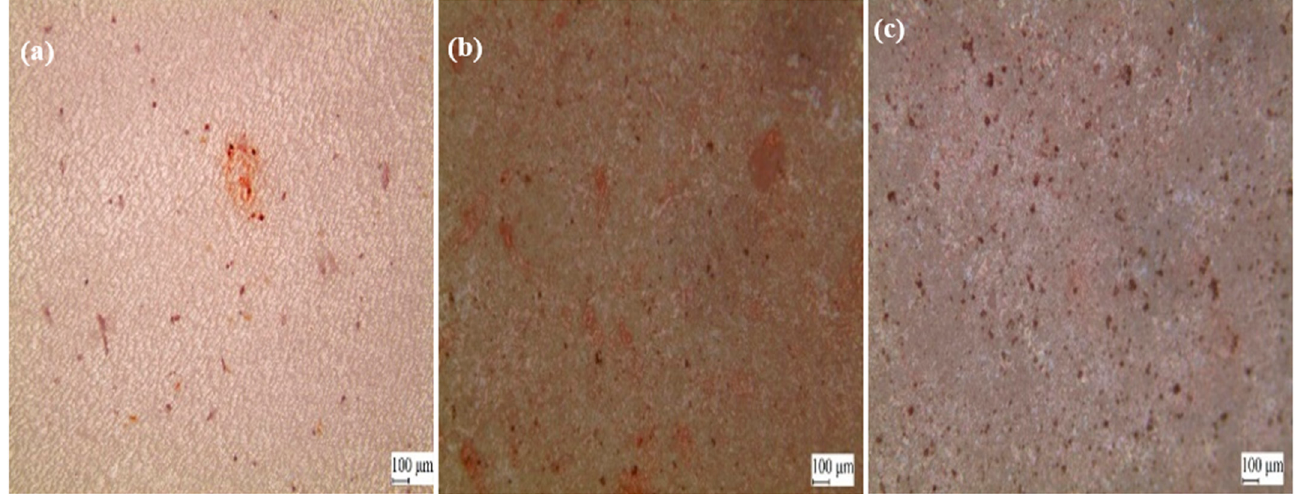
Figure 8. Alizarin red staining of MC3T3-E1 cells cultured on pristine PEEK ( a ), P-PEEK ( b ), and P- PEEK-Col ( c ). MC3T3-E1 cells were cultured for 14 days at 37 °C at a cell density of 5 × 10 4 cells/mL in circular PEEK disks placed in wells of a 24-well cell culture plate. After removing the medium, the adhered cells were fixed with 10% formaldehyde aqueous solution. Thereafter, alizarin red staining was performed on the cultured cells. Digital images were captured with an optical micro- scope equipped with an advanced camera to obtain images of cells stained with alizarin red in PEEK samples.